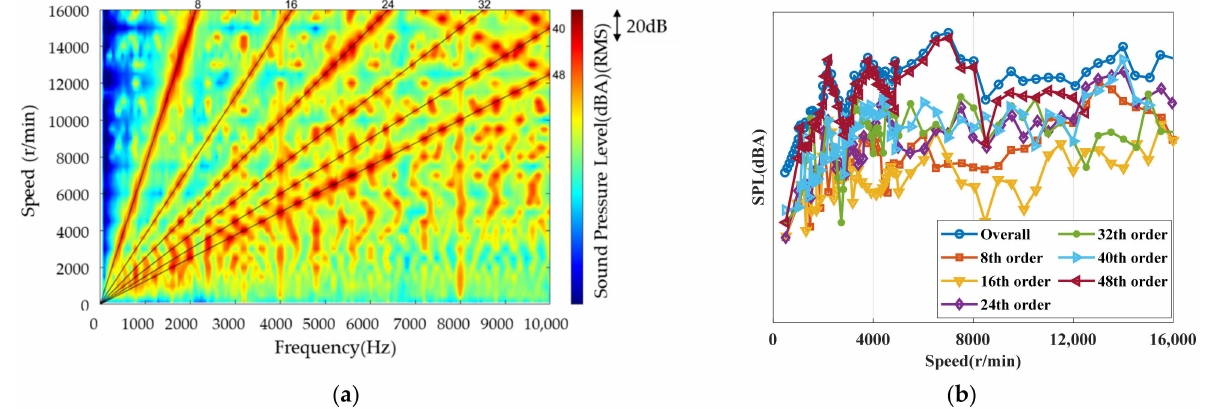
Figure 5. Rear 1 m acoustic measurement point location noise results. ( a ) Microphone sound pressure level colormap results; ( b ) Overall level and order cut level of Microphone sound pressure.